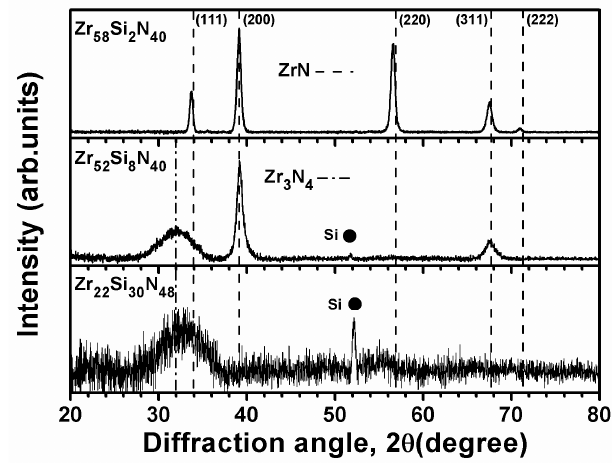
Figure 4. XRD patterns of Zr 58 Si 2 N 40 (0.4,R5), Zr 52 Si 8 N 40 (0.4,R5), and Zr 22 Si 30 N 48 (0.4,R5) coatings.